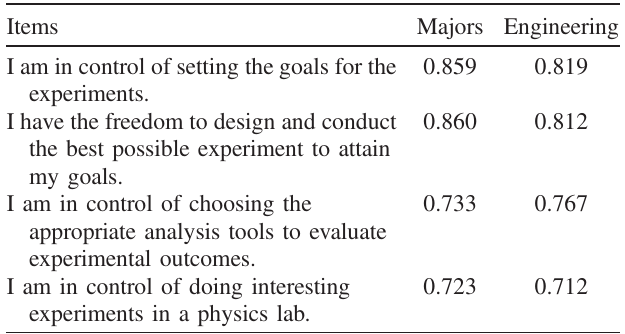
TABLE I. Sense of agency items and their factor loading ( λ ) values for both physics courses are shown